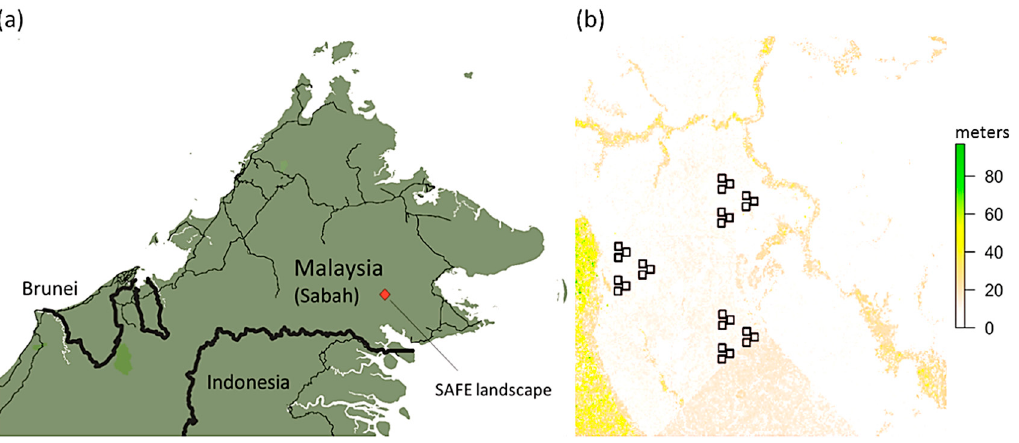
Figure 1. Panel ( a ) shows the location of the Stability of Altered Forest Ecosystem (SAFE) landscape within Sabah, Malaysia and ( b ) the LiDAR Canopy Height Model (greener shades corresponding to higher heights in metres) of the SAFE Project landscape including 27 plots located in oil palm plantations.